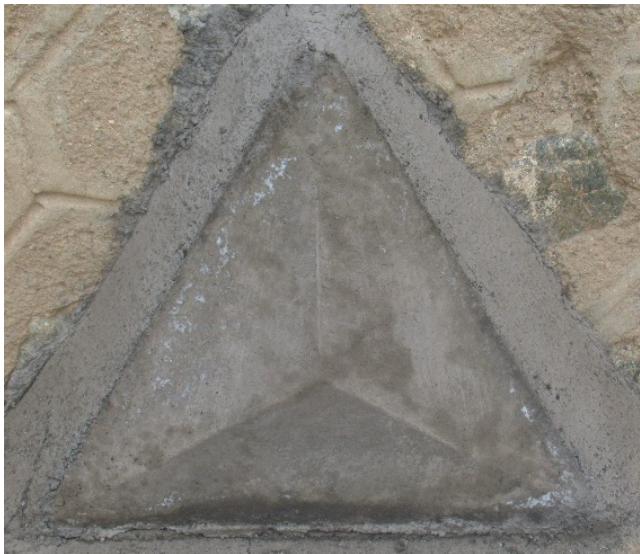
Figure 8. Triangular pyramid target.